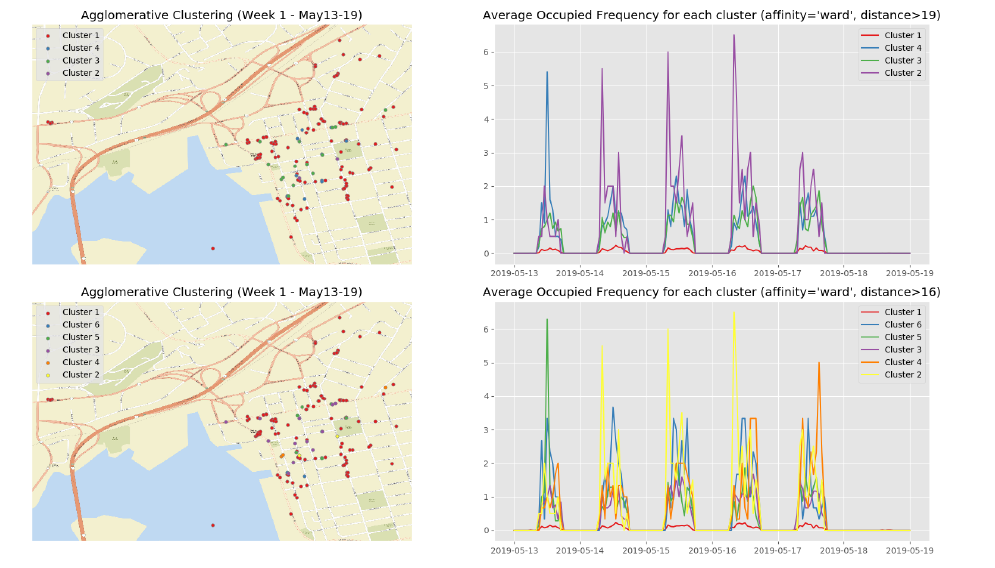
Figure 13. Clustering result of the first observation week (13 May–19 May).